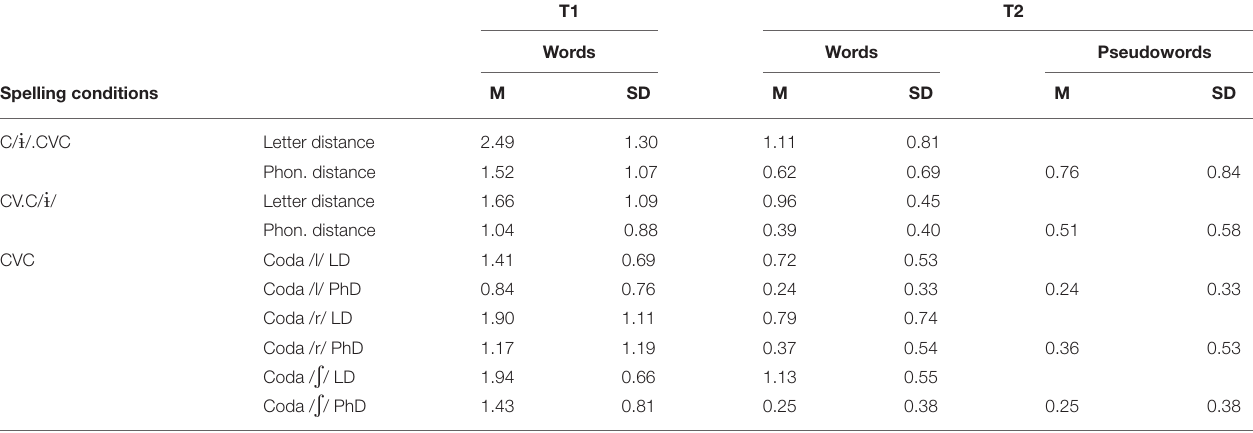
TABLE 3 | Spelling means and standard deviations using letter distance and phoneme distance scorings.